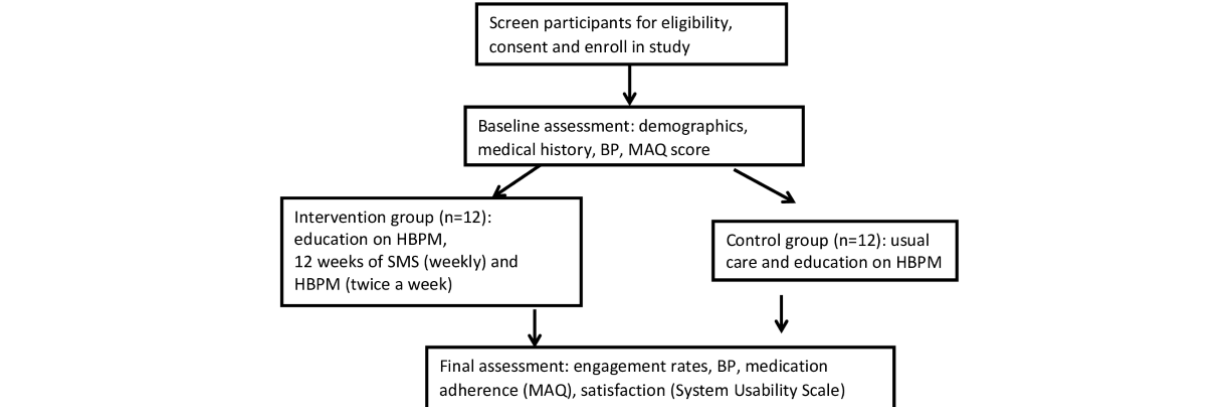
Figure 2. Study algorithm. BP: blood pressure; HBPM: home blood pressure monitoring; MAQ: Medication Adherence Questionnaire.